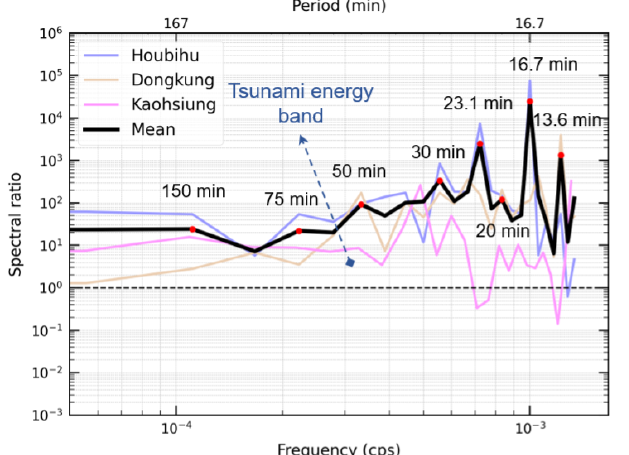
Figure 11. Respective spectral ratios for the tide gauge spectra. The solid black line is the calculated mean spectral ratio of the three tide gauge spectra. The red circles represent the dominant periods of the mean spectral ratio.